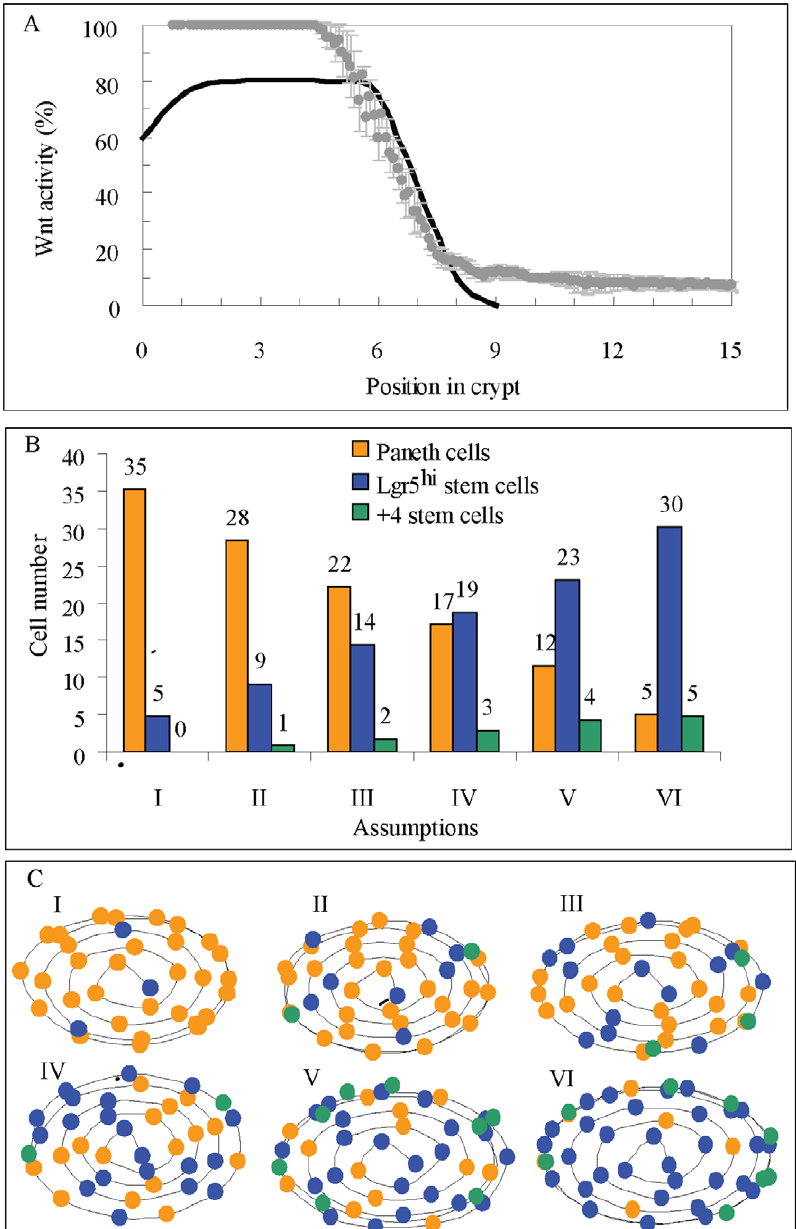
Figure 2. Modelling Wnt and Notch signalling in Paneth cells intermingled with Lgr5 hi stem cells at the crypt base. A) Wnt signalling activity (grey circles) as simulated by our model and measured experimentally (solid line) [28]. A Wnt activity level of 1 (Equation 1) is equivalent to 100%. The results shown were obtained from 30 simulated crypts. B) Number of Paneth or Paneth progenitor and stem cells at the bottom of the crypt under high Wnt signalling activity (100%) assuming that a newly generated cell differentiates into a common goblet Paneth cell progenitor if in contact with 1 or more stem cell; otherwise secretory fate is inhibited by Notch signalling (hypothesis I). Similarly, hypotheses II, III, IV, V and VI assume that newly generated cell differentiate into a Paneth cells if in contact with a number of stem cells equal or greater than 2, 3, 4, 5 and 6, respectively. The total number of cells in contact is 6. Hypothesis III, which states that secretory fate of a stem cell is inhibited by Notch signalling if it is in contact with more than 50% of cells that belong to the secretory lineage, which best fits empirical observations. The results shown are from 30 simulated crypts. Coefficient of variation for the number of cells (CV = standard deviation/mean) varied from 0.015 to 0.04 in all cases. C) Upper view of the distribution of Paneth and stem cells in the crypt base at day 20 according to the six hypotheses. doi:10.1371/journal.pone.0037115.g002 [37]. Thus, Paneth cells expressing EphB could detach when signalling, which controls cell compartmentalization of Paneth cells in the bottom of the crypt [16]. Shedding of E-cadherin forced into a monolayer of absorptive progenitors expressing molecules has been reported in the boundaries between compart- ephrin-B that restricts their adhesion. As the majority of apoptotic mentalized populations of EphB- and ephrin-B expressing cells cells are located at the bottom of the crypt in the stem cell area,